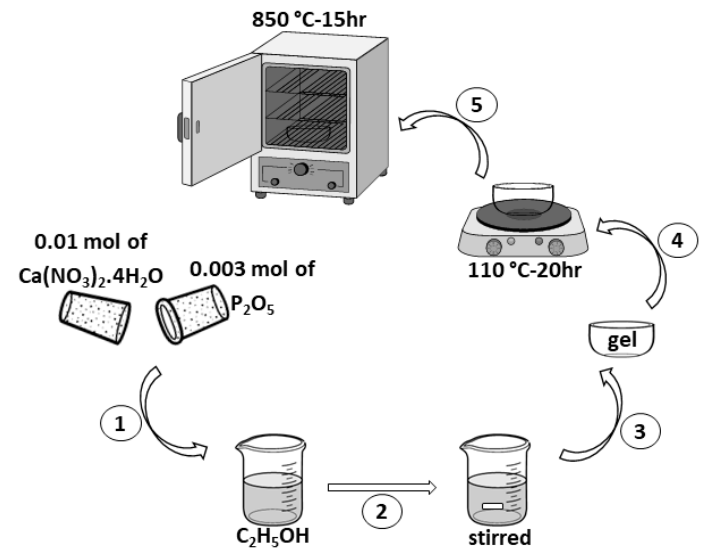
Figure 1. The schematic flow diagram of the synthesis route of HA.